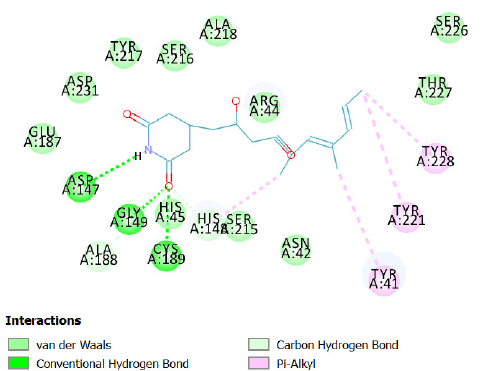
Fig. 6A. 2D diagram showing interactions of 9-Meth- ylstreptimidone at LGMN catalytic